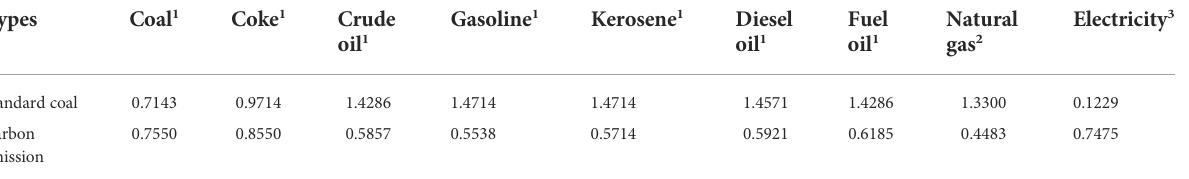
TABLE 3 Carbon emission coef fi cient of energy